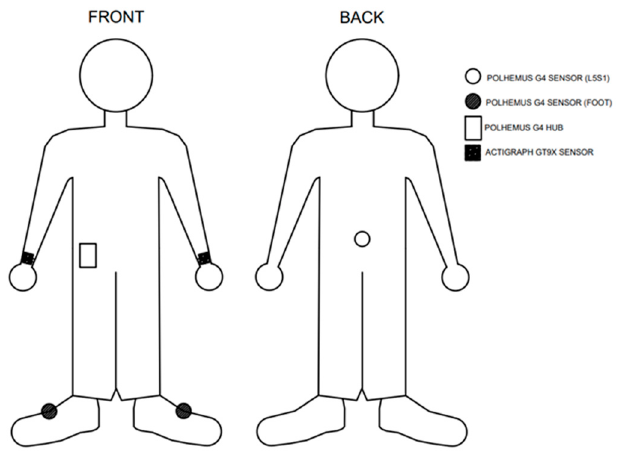
Figure 2. A diagram of the sensor locations on the participant’s body. The Polhemus G4 sensors (circles) are attached to each shoe and to the participant’s back, the Polhemus G4 hub is worn on the waistband, and the ActiGraph GT9X sensors (squares) are worn on the wrists.